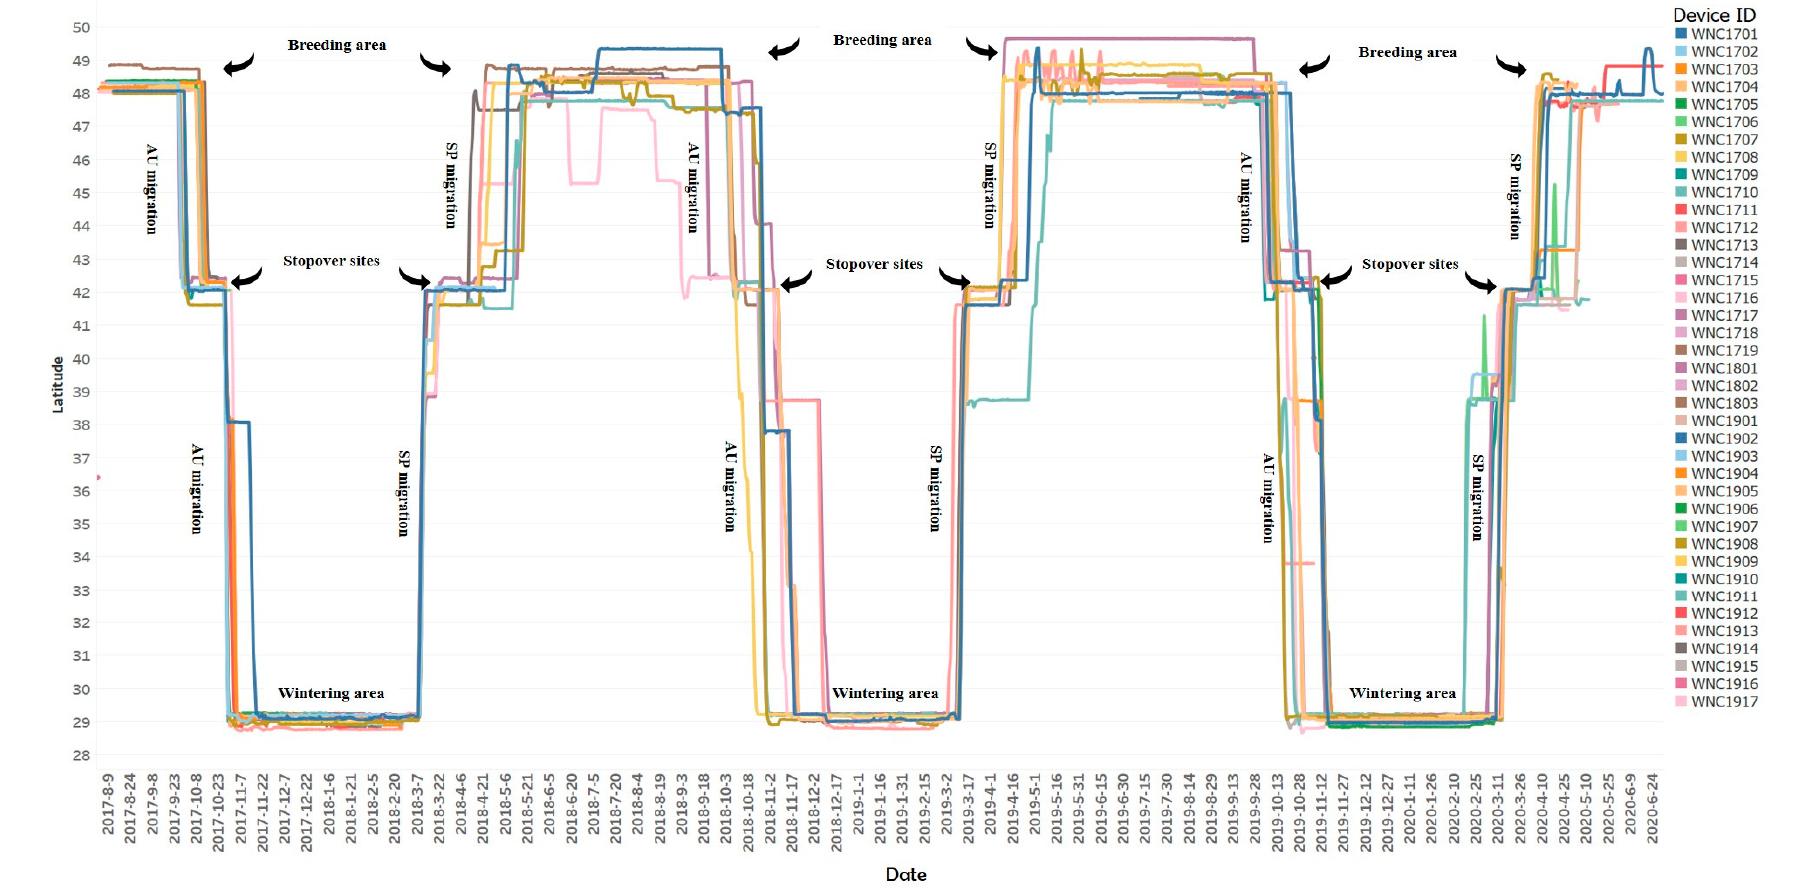
Figure 1. Schematic overview of three years of movement patterns of tagged white-naped cranes ( Antigone vipio ) followed from capture on their Mongolian breeding areas to Poyang Lake wintering area from 2017 to 2020. Each trace represents a given individual (identified to the right, with the code that identifies birds described in Supplementary Materials Table S1) illustrated for the period for which it generated data.